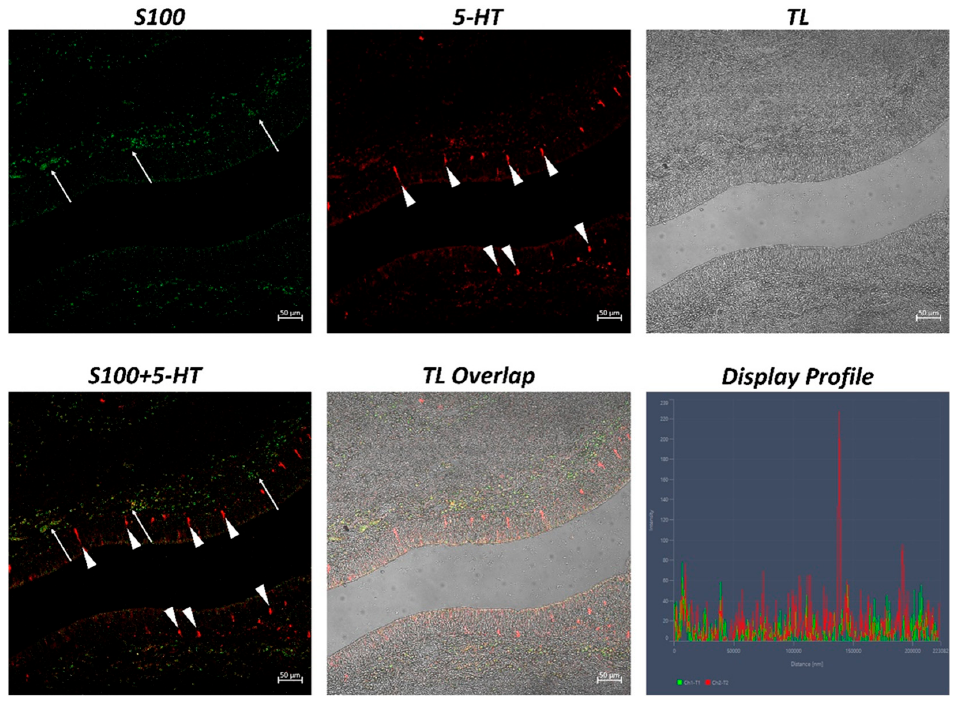
Figure 4. Section of the H. niloticus gut (immunofluorescence 20 × , scale bar 50 µ m). Immune cells that are positive for S100 are evident in the submucosa (arrows), while the neuroendocrine cells (5-HT positive) are evident in the epithelium (arrowheads). The “Display profile” function highlights the absence of colocalization. TL = transmitted light.